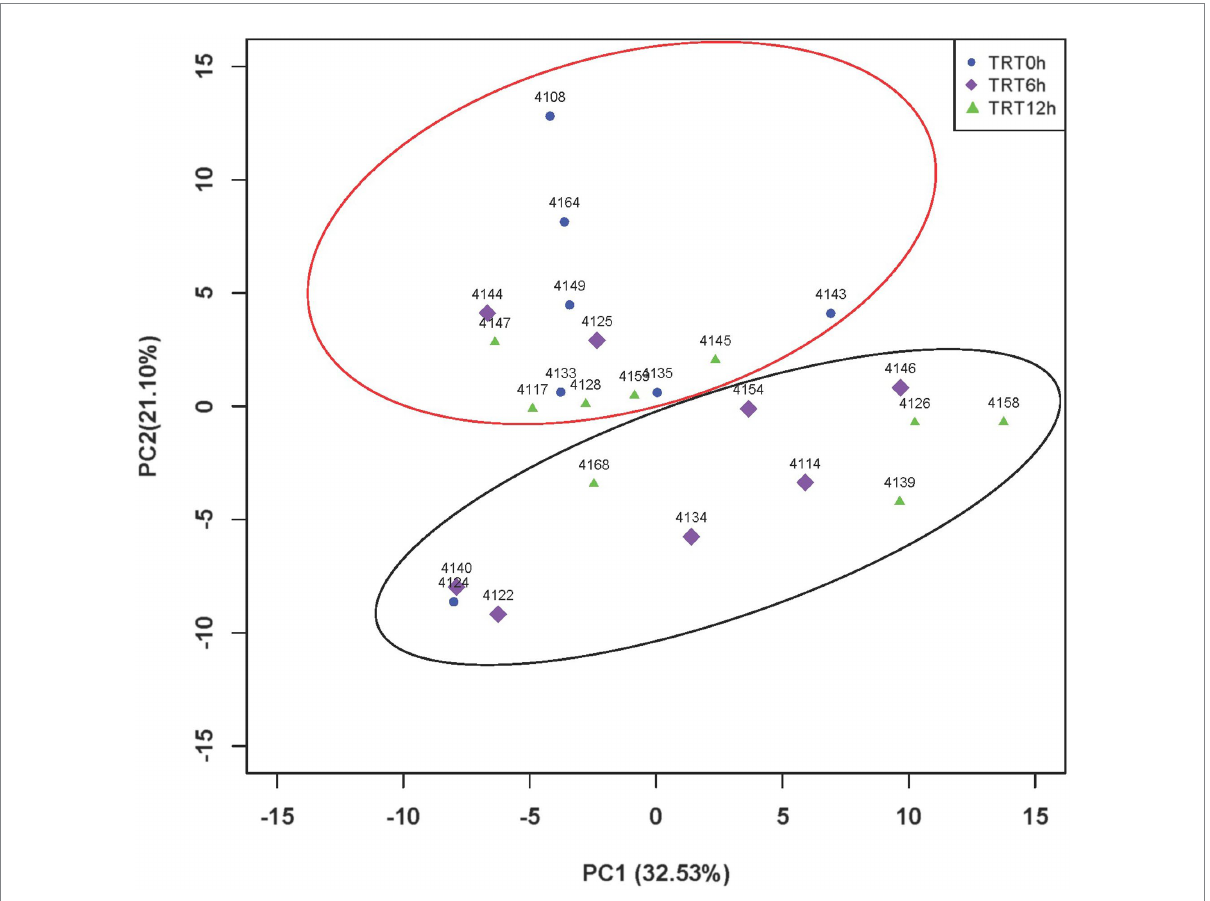
FIGURE 3 PCA plot of KEGG pathways among different treatments. Principal component analysis (PCA) plots of colon microbial metabolic Kyoto Encyclopedia of Genes and Genomes (KEGG) pathways among three colostrum feeding time treatments in neonatal dairy calves. TRT0h, TRT6h, and TRT12h indicate calves were fed colostrum at 45 min, 6 h, and 12 h after birth, respectively. PC1, principal component 1; PC2, principal component 2.